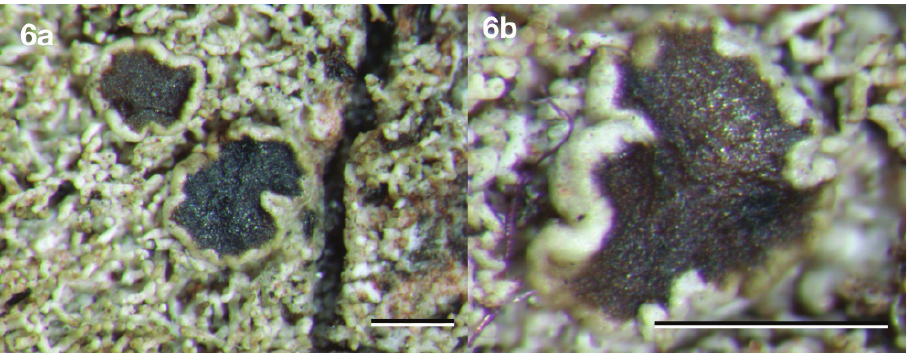
Figure 6. Neoprotoparmelia brasilisidiata , holotype Cáceres & Aproot 21684 (ISE). Scale bar: 1